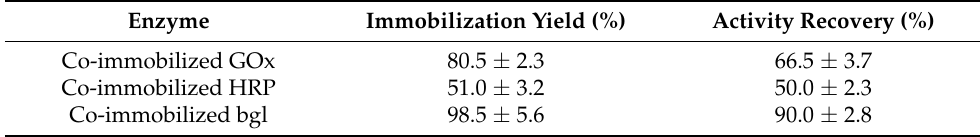
Table 1. Immobilization yield (%) and activity recovery (%) of GOx, HRP, and bgl co-immobilized on bG.